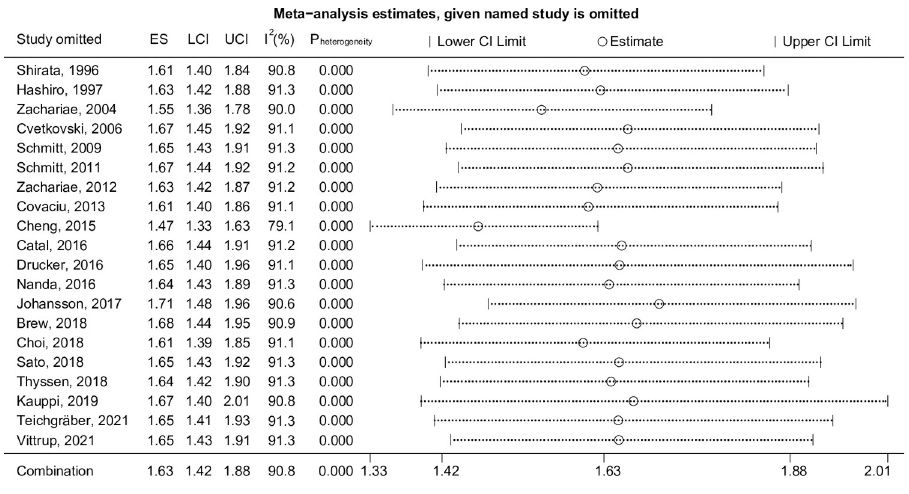
Fig 3. Sensitivity analysis of eczema associated with anxiety/depression.